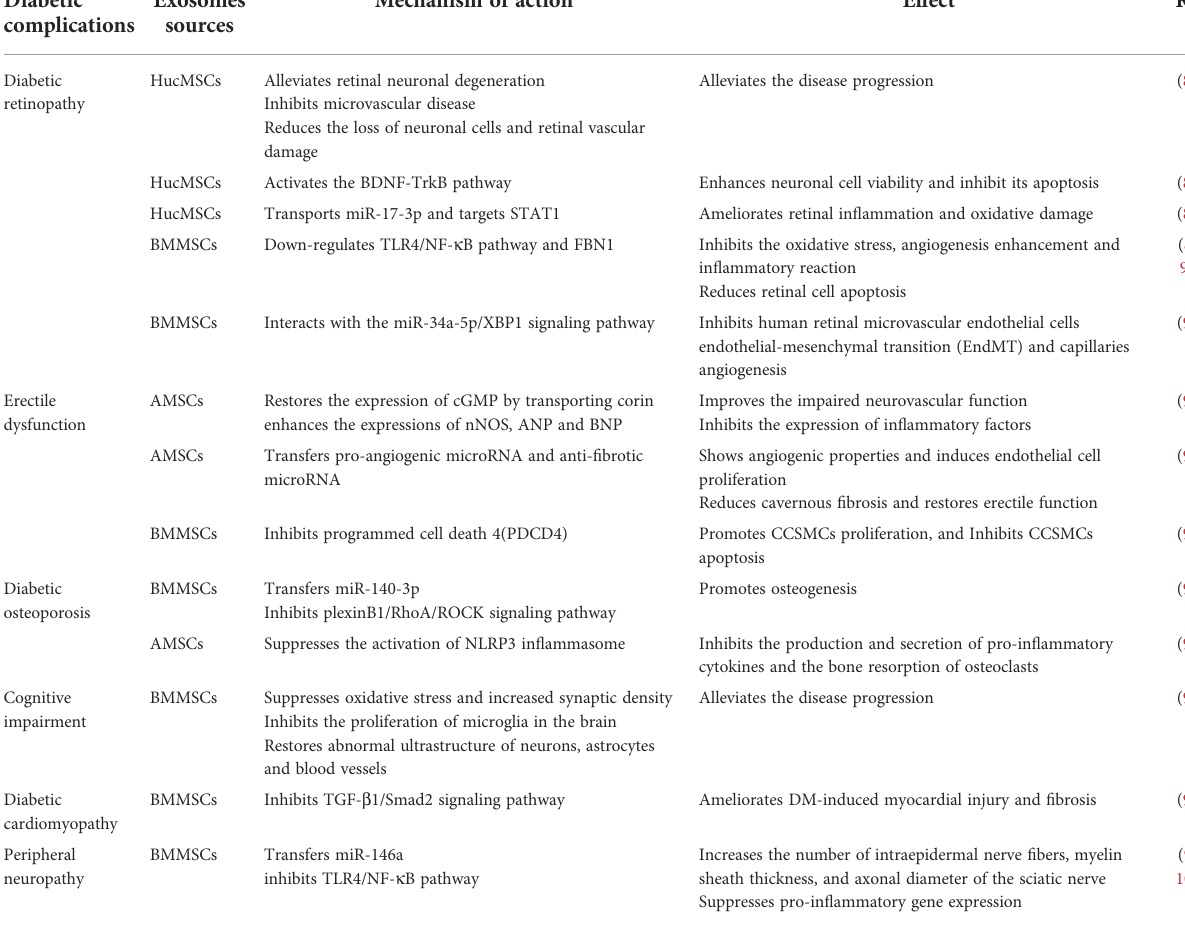
TABLE 1 The role of mesenchymal stem cell-derived exosomes in other diabetic complications. Diabetic Exosomes complications